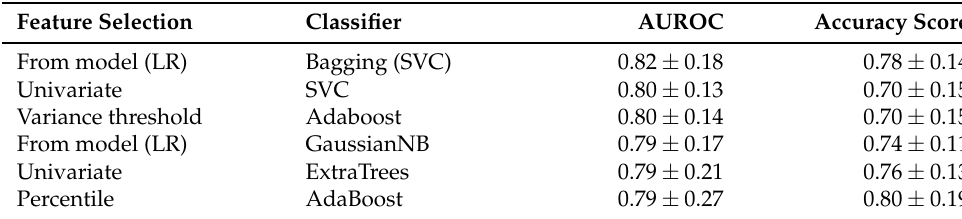
Table 6. Selected pipelines results ordered by AUROC.